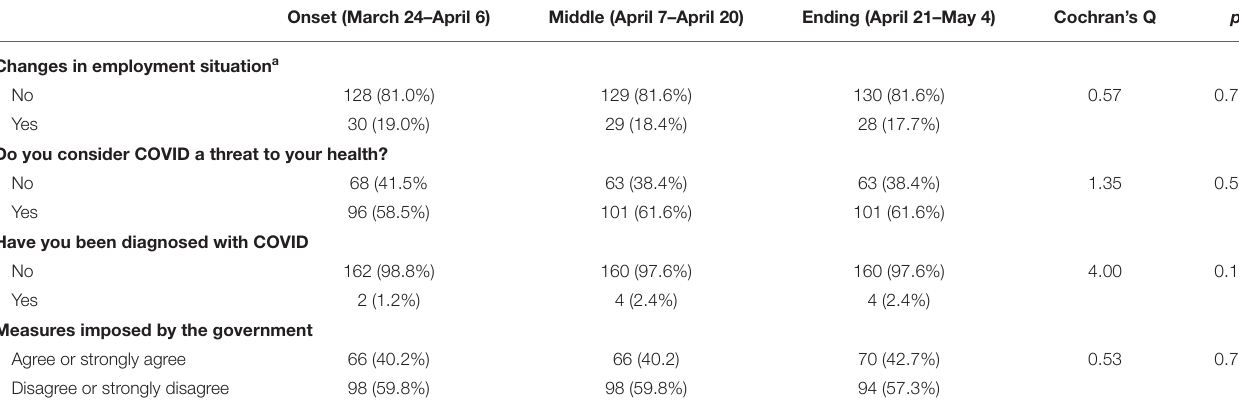
TABLE 5 | Comparison of response percentages in the qualitative questions in the three